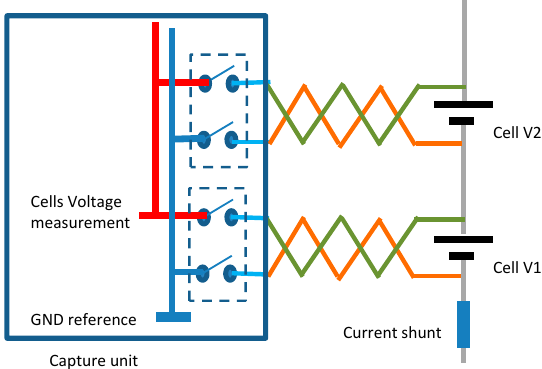
Figure 5. Cells measurement configuration.